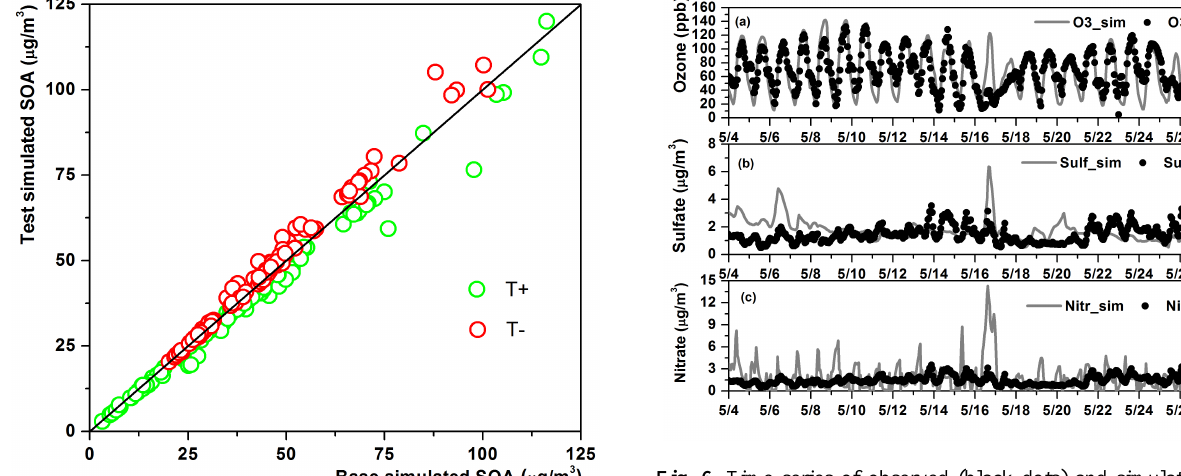
Fig. 6. Time series of observed (black dots) and simulated (gray line) (a) ozone, (b) sulfate and (c) nitrate in Cabauw May